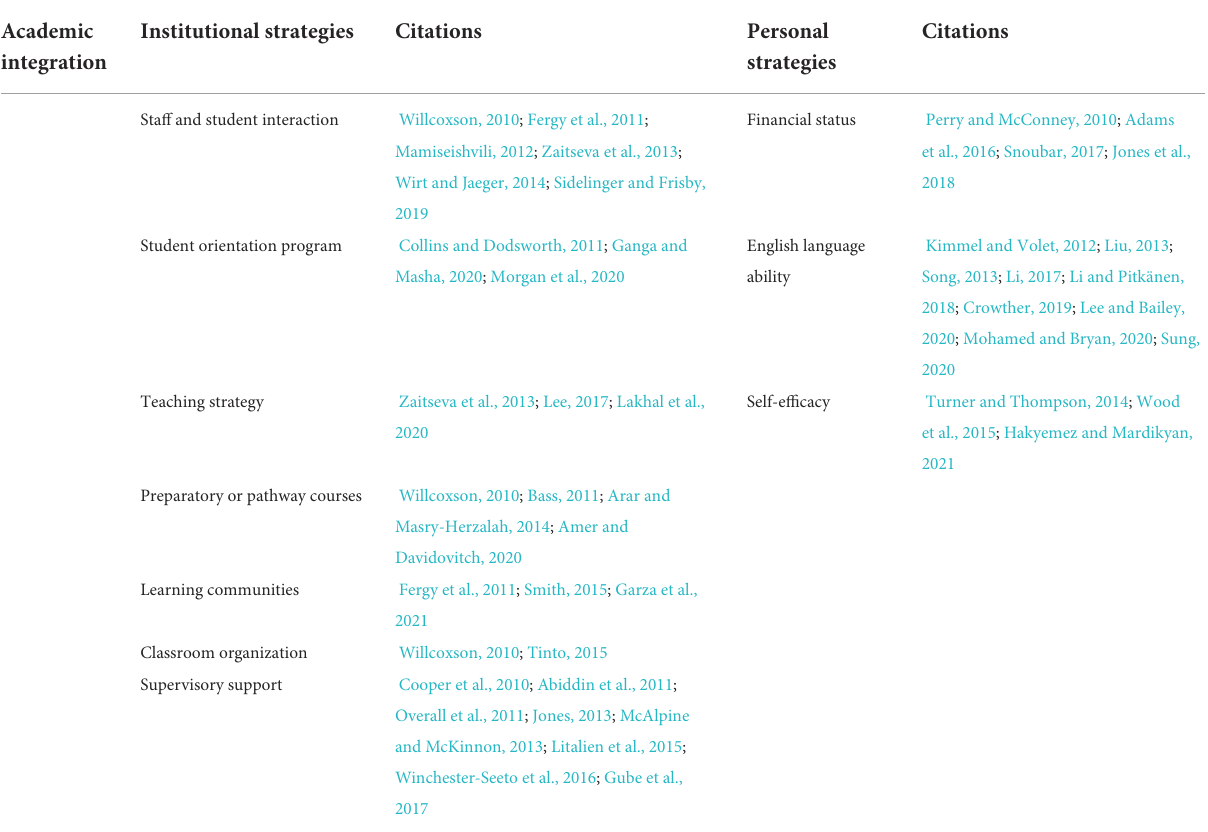
TABLE 1 Strategies found to promote academic